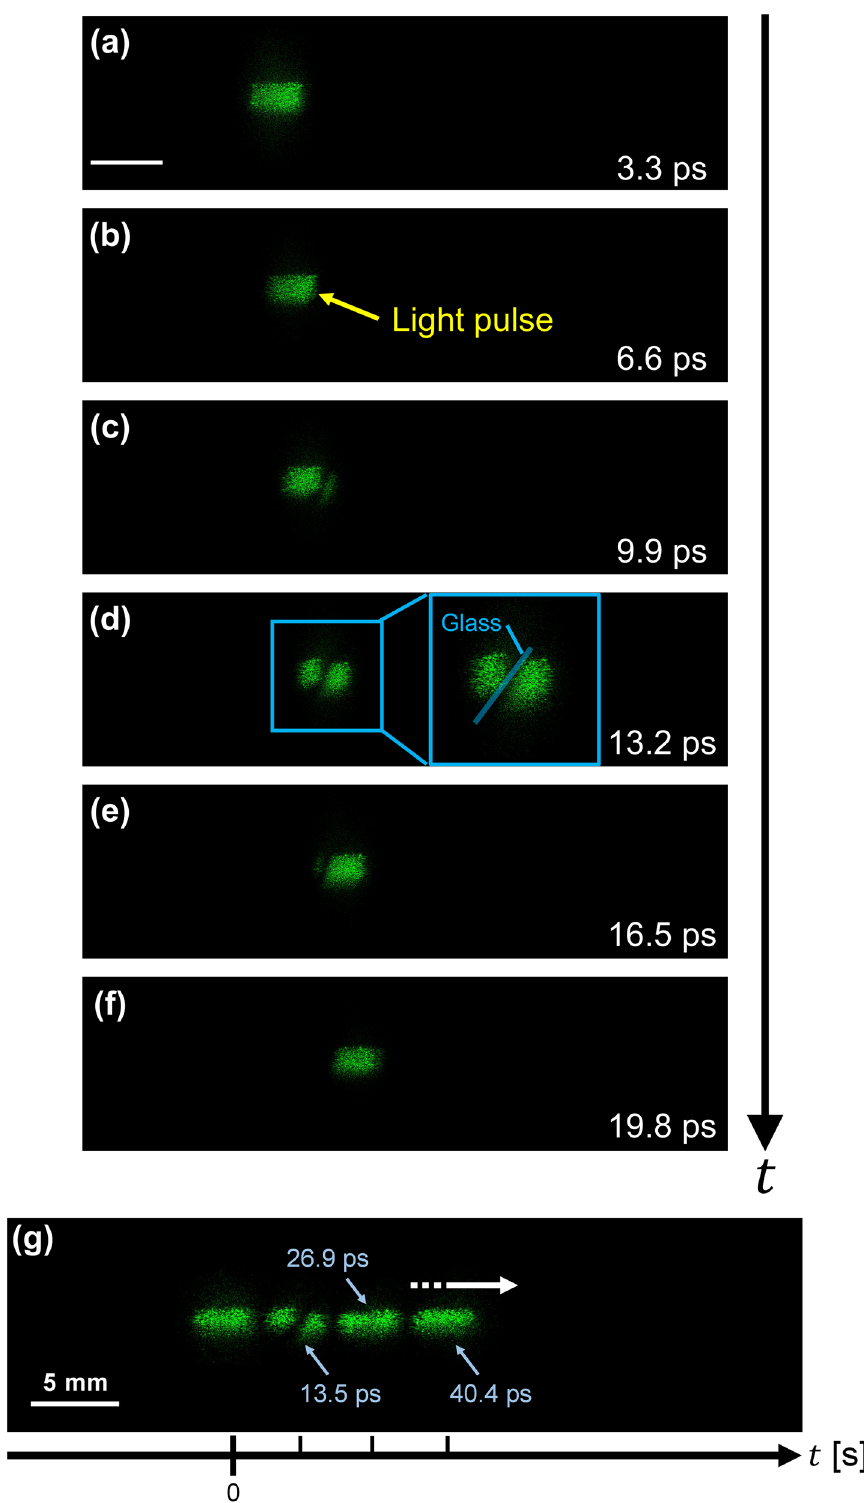
Figure 4. Frames extracted from the motion picture of the reconstructed images. ( a – f ), Propagating light pulse in the 3-D scattering medium. The light pulse was propagating from left to right (see Video S2). The time interval between each picture was 3.3 ps. The light pulse has not yet reached the glass in ( a ) and ( b ). The light pulse is entirely in the glass and refracted in ( c – e ). The light pulse has left the glass in ( f ). Scale bar: 5 mm. ( g ) Figure shows the temporal change of the light pulse propagation by combining some reconstructed images. The striped arrow indicates the direction of the light pulse